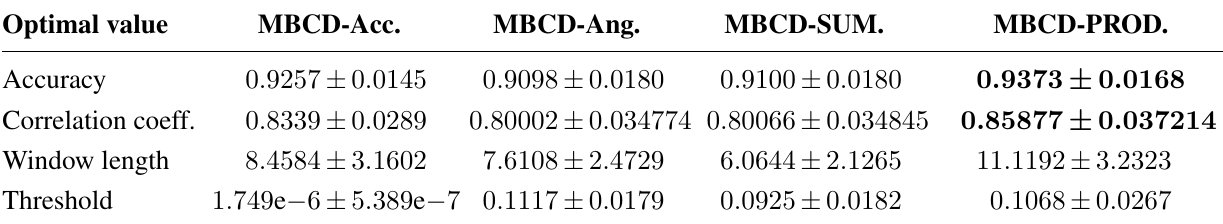
Table 5. Results of the Monte Carlo simulation ( N = 500 ). Synthesized signals. Average Accuracy, Correlation coefficient and associated parameters (Memory Based CUSUM Detector).